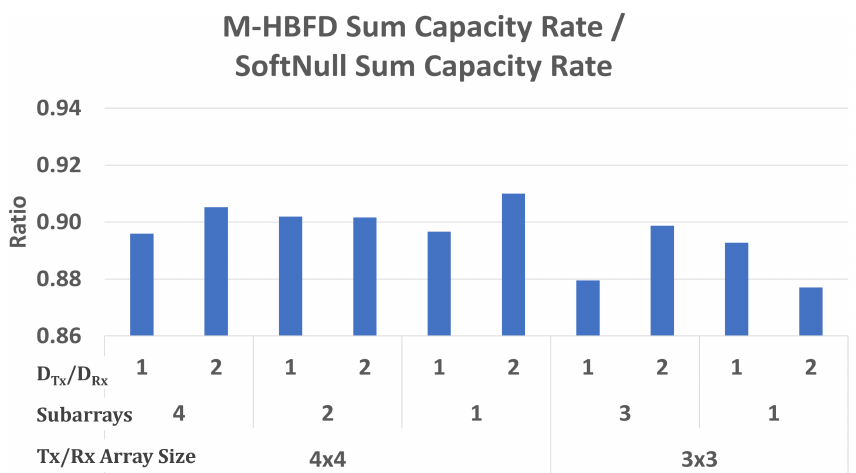
Figure 8. Effect of array size ((bottom), denoted by Tx/Rx Array Size row), number of subarrays ((middle), denoted by Subarrays row), and number of effective antennas per row ((top), denoted by D Tx /D Rx row) on capacity compared to SoftNull.